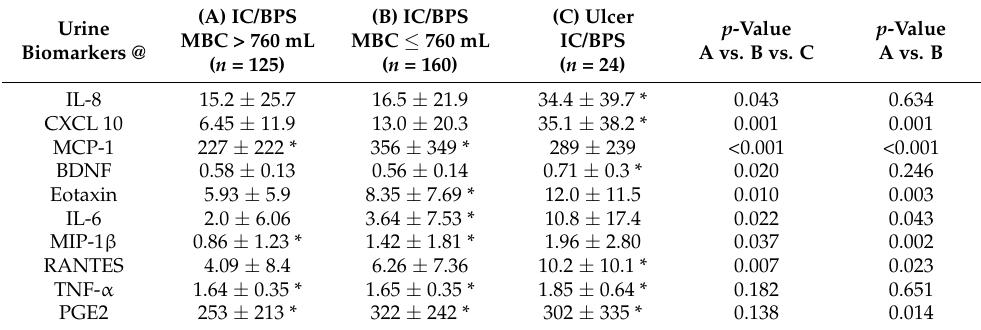
Table 2. The urine biomarkers among IC/BPS subgroup patients with different maximal bladder capacity and Hunner’s IC